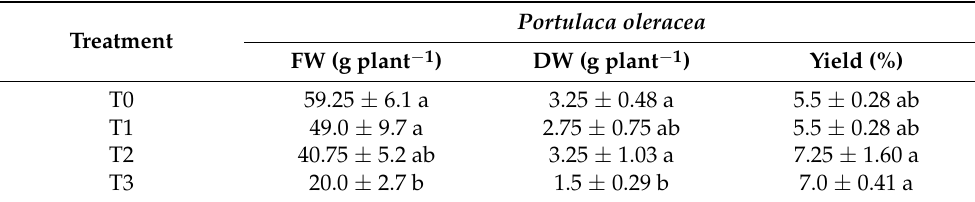
Table 4. Yield of P. oleracea (in the first experiment). Different letters within a column represent significant differences ( p ≤